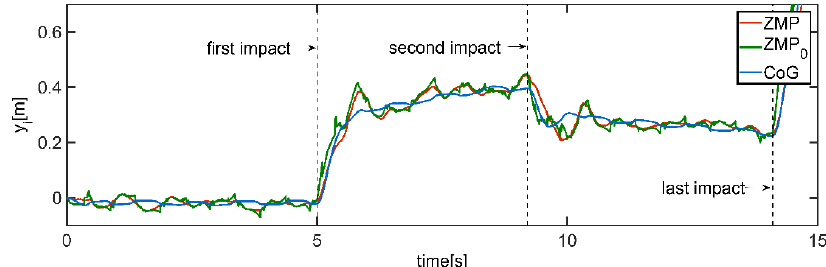
Figure 27. Positions of ZMP , ZMP 0 , and CoG in the 𝑦 𝑖 direction.